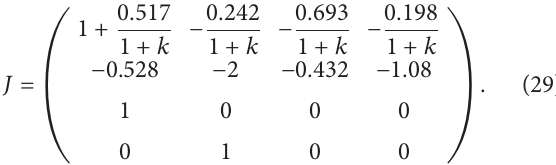
system (10) show the messy chaos phenomenon, the external variable parameter 𝛾 𝐴 is in a stable area. Analysis under the controlled system (26) in this parameter values of the chaos represents the stability of the new system (26). The parameter values in the system use (26) the Jacobian matrix as